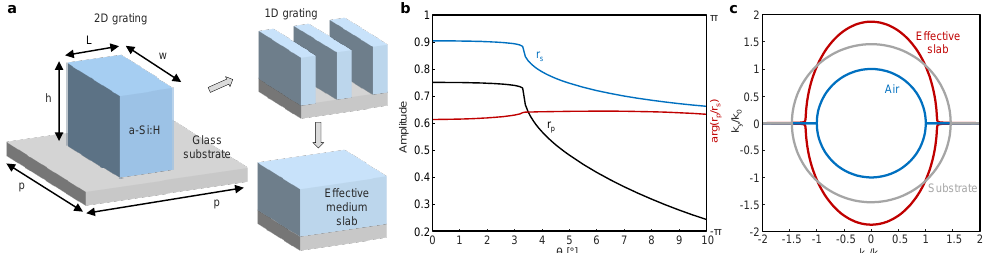
Figure 3. Single-layered dielectric metasurface for the strengthened SHEL under circularly polarized incidence. ( a ) Schematic of the metasurface and its homogenization to 1D grating and slab. ( b ) Reflec- tion coefficients (black for p and blue for s polarizations, respectively) and their phase difference (red). ( c ) Equifrequency curves of the homogenized metasurface (red), substrate (gray), and air (blue). In contrast to the π phase difference between r p and r s at the